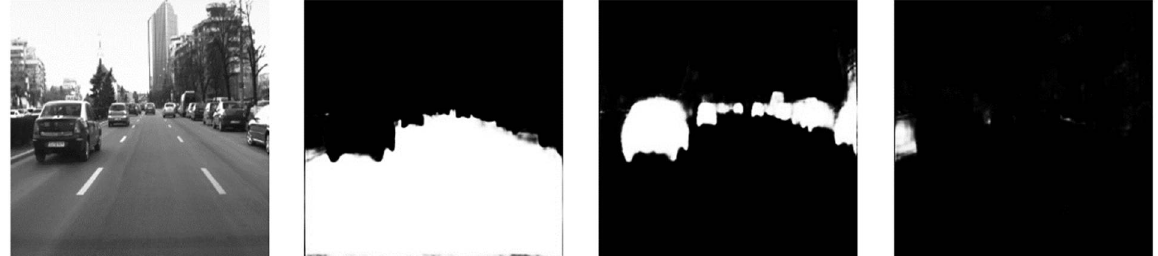
Figure 5. Examples of the global semantic segmentation output: the first image is the color input image of the road scene, while the second image represents the drivable road area, the third represents the dynamic objects, and the fourth image is static objects (sidewalk or fence).